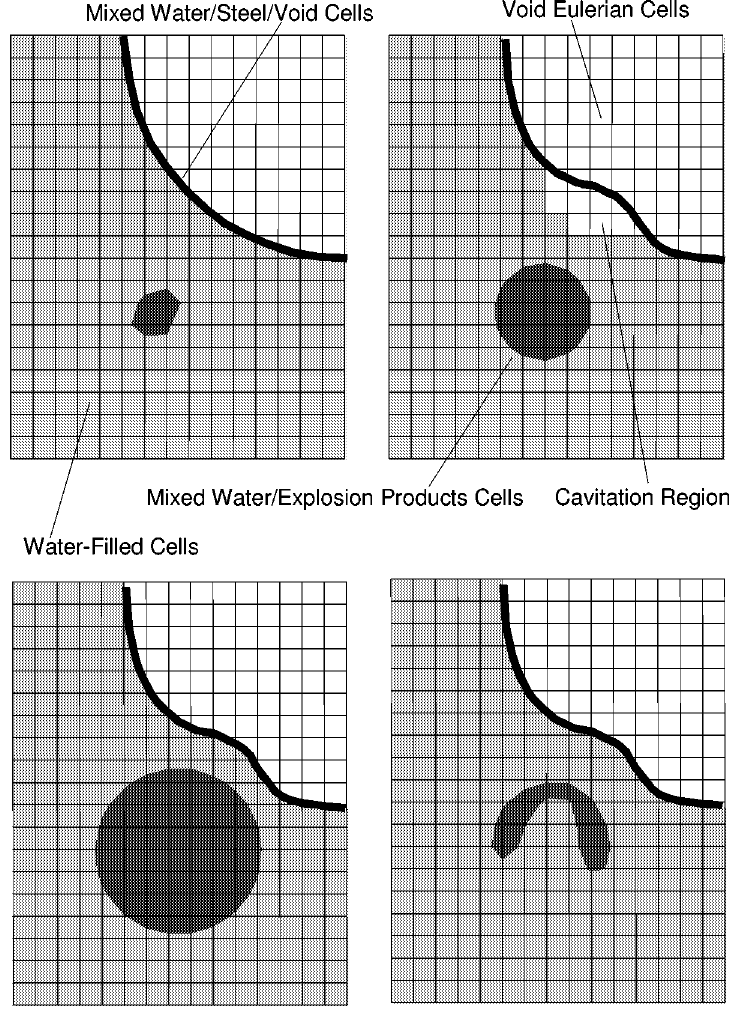
Fig. 5. Eulerian hydrocode UNDEX-SMI